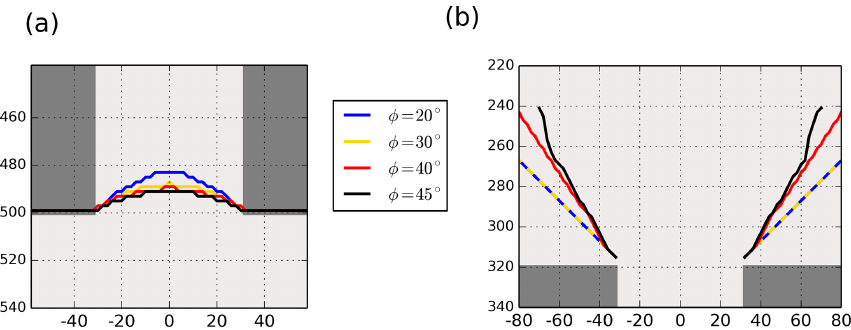
Figure 12. The shape of the lines of fracture using different angles of internal friction: (a) for the downstream ice arches and (b) for the upstream lines of fracture (the yellow and purple lines are